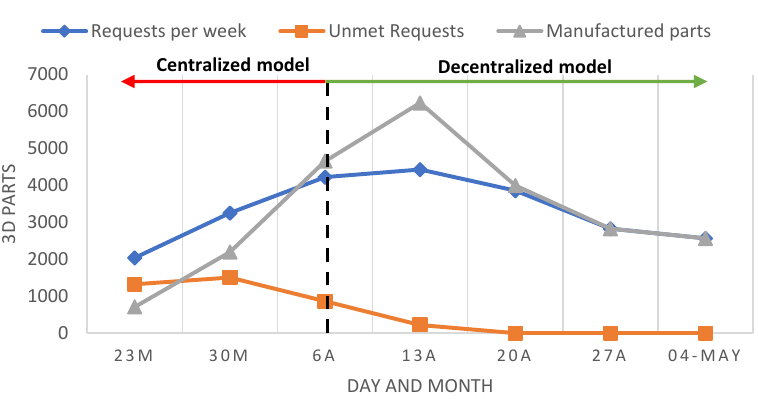
Figure 14. Production rate of both centralized and decentralized systems within the studied/considered period. The relation among requests per week (blue line), unmet requests per week (orange line), and manufactured parts (grey line) per week is